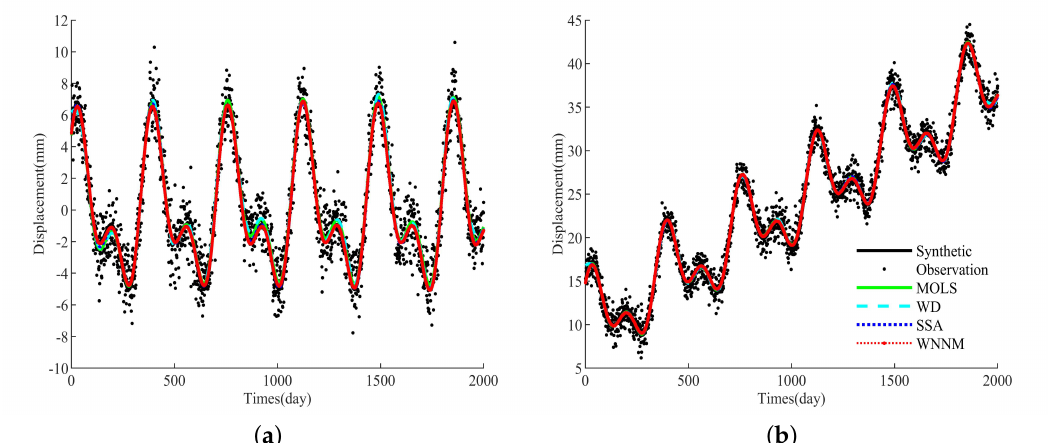
Figure 1. Comparison between extracted signal and original Global Navigation Satellite System (GNSS) time series, where σ f = 1 mm/yr − k 4 . Black scatter shows GNSS observed time series, black solid line represents the simulated GNSS time series and green, cyan, blue and red lines represent signals extracted by applying moving ordinary least squares (MOLS), wavelet decomposition (WD), singular spectral analysis (SSA) and Weighted Nuclear Norm Minimization (WNNM), respectively. ( a ) Without trend and ( b ) with a linear